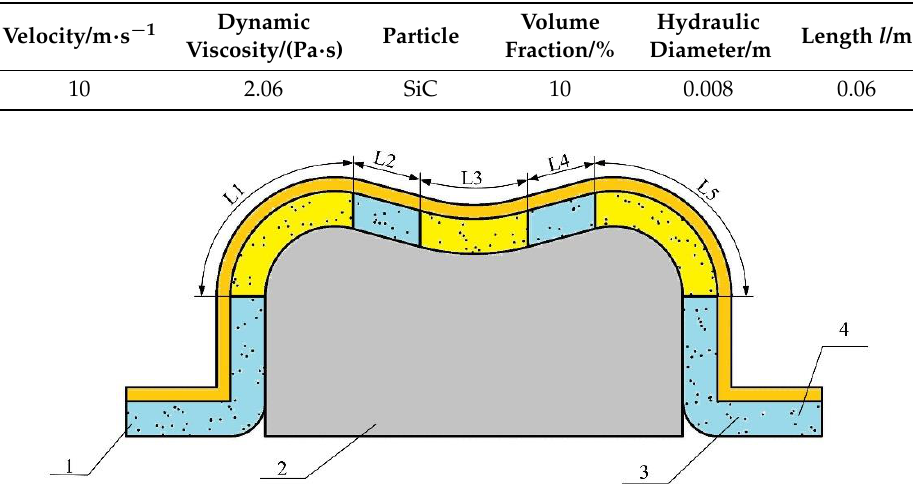
Figure 8. Division of curvature region: 1, inlet; 2, workpiece; 3, constrained flow passage; 4, outlet.